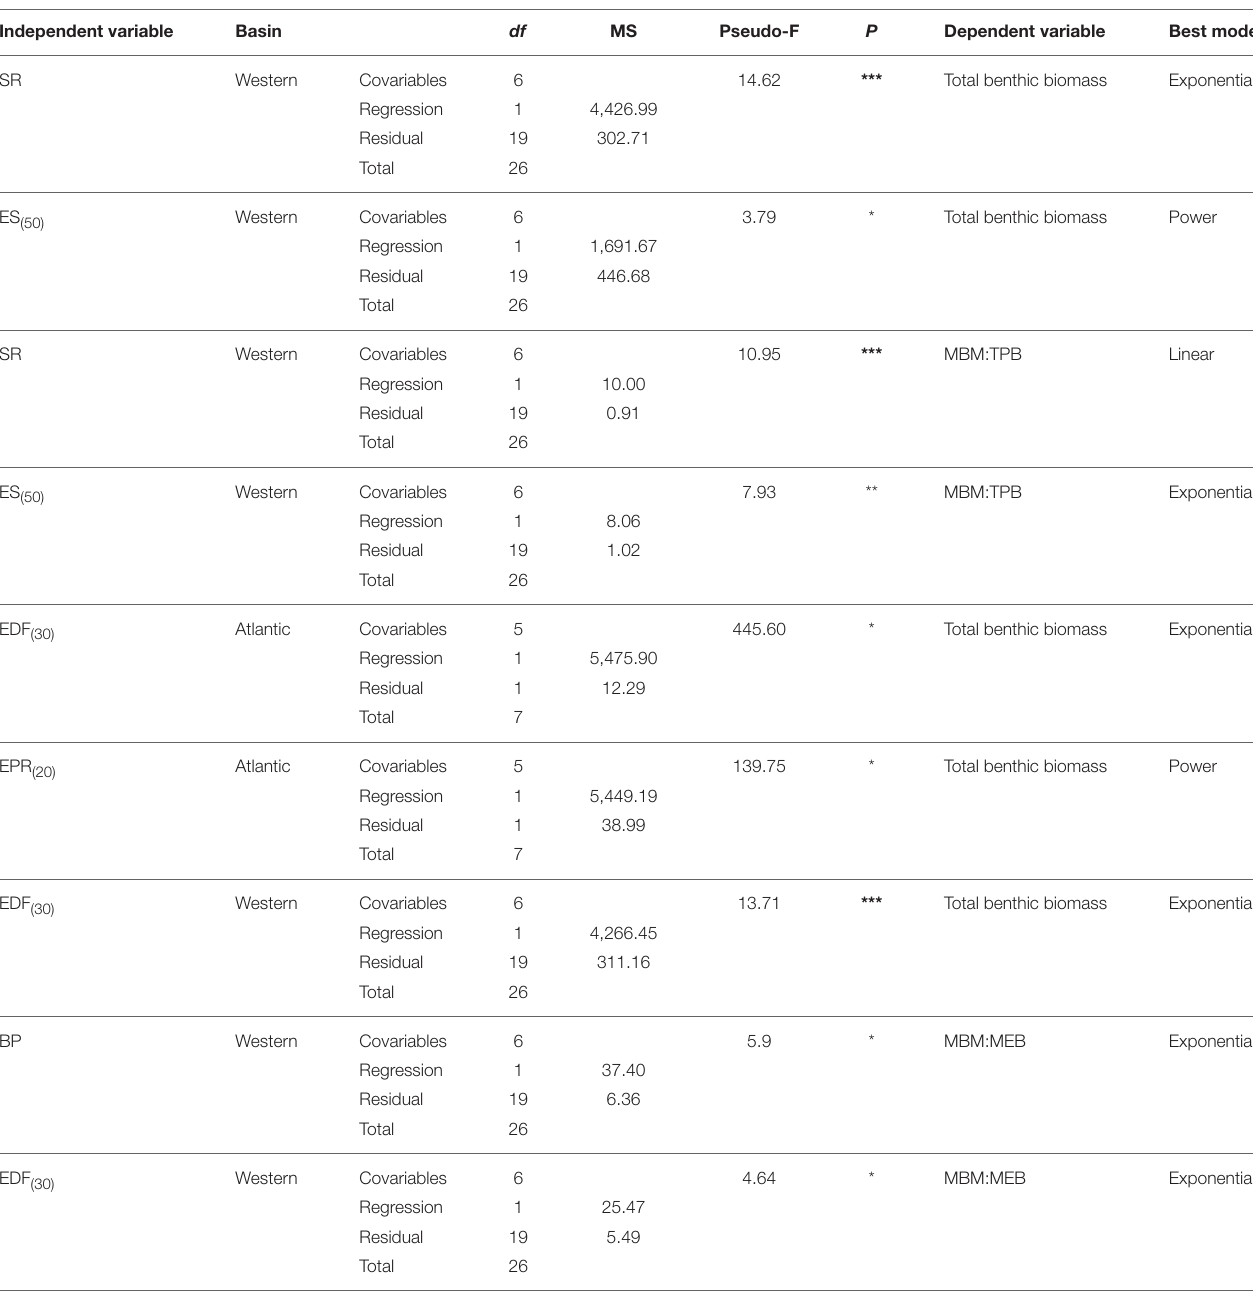
TABLE 5 | Basin-scale